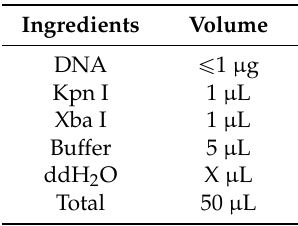
Table 2. Composition of the enzyme digestion reaction.